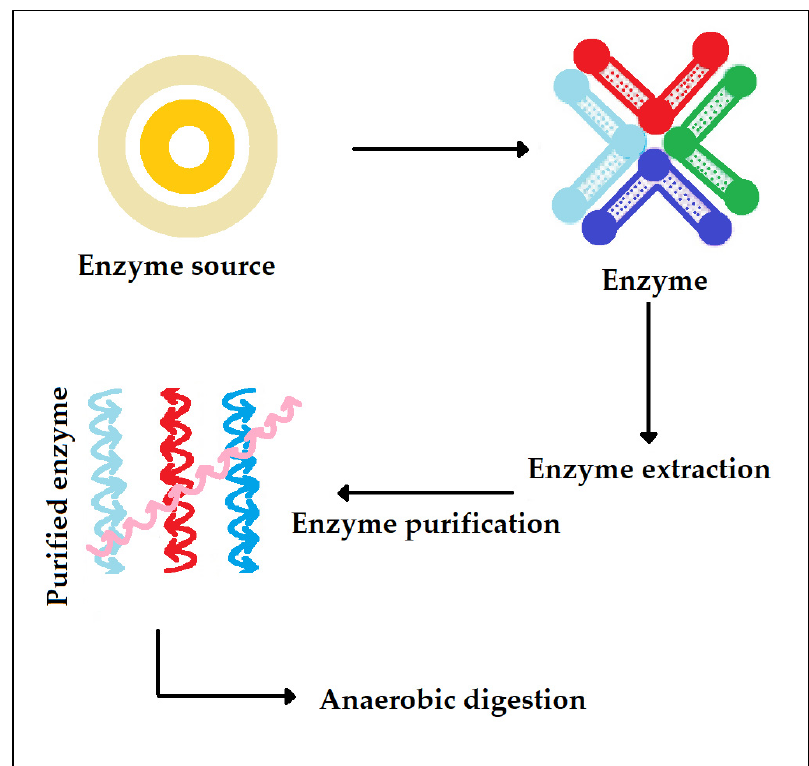
Figure 7. Extraction of enzyme for application in anaerobic digestion.